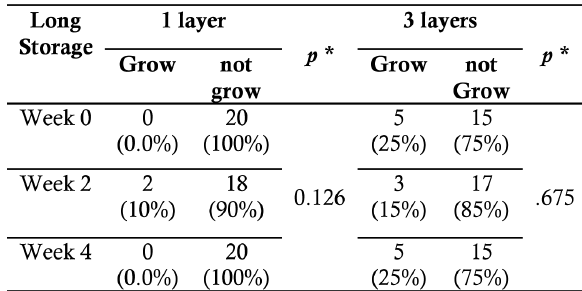
Microbial Growth of Sterile Gauze 1 And  Layer Perchment Paper and Storage